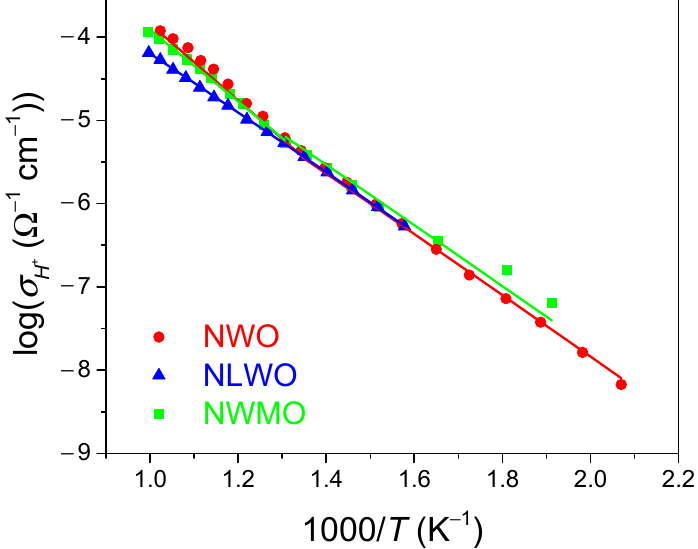
Figure 6. Protonic conductivity of samples synthesized by the mechanical activation and sintered using electron beams: NWO (red plot), NLWO (blue plot), NWMO (green plot).